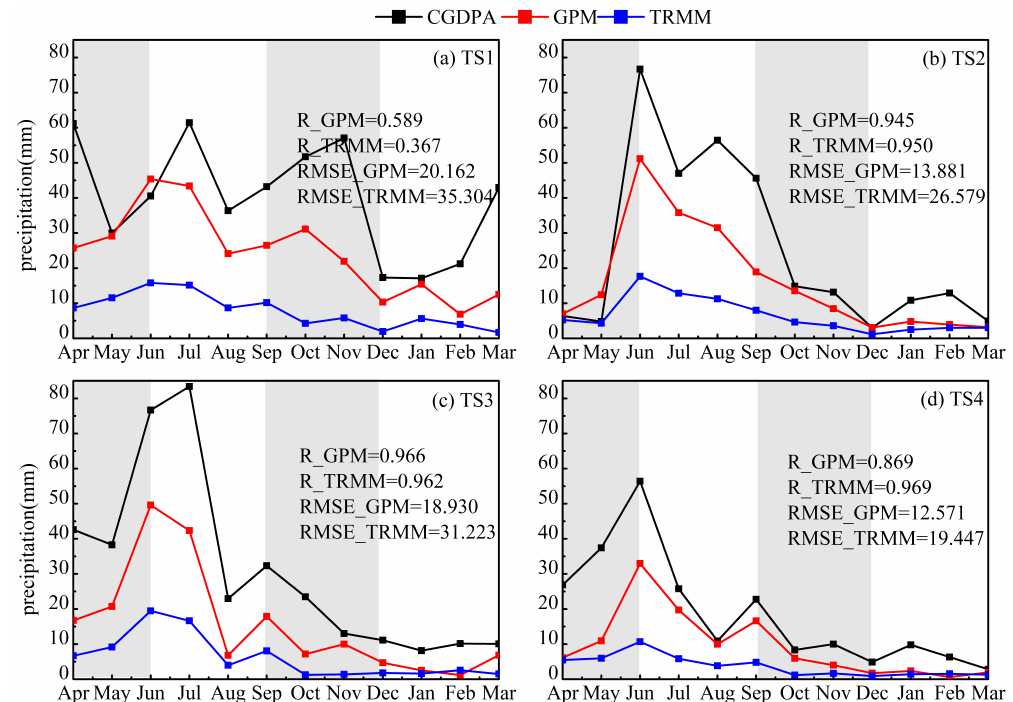
Figure 6. Annual variation in precipitation in four subregions of the Tianshan